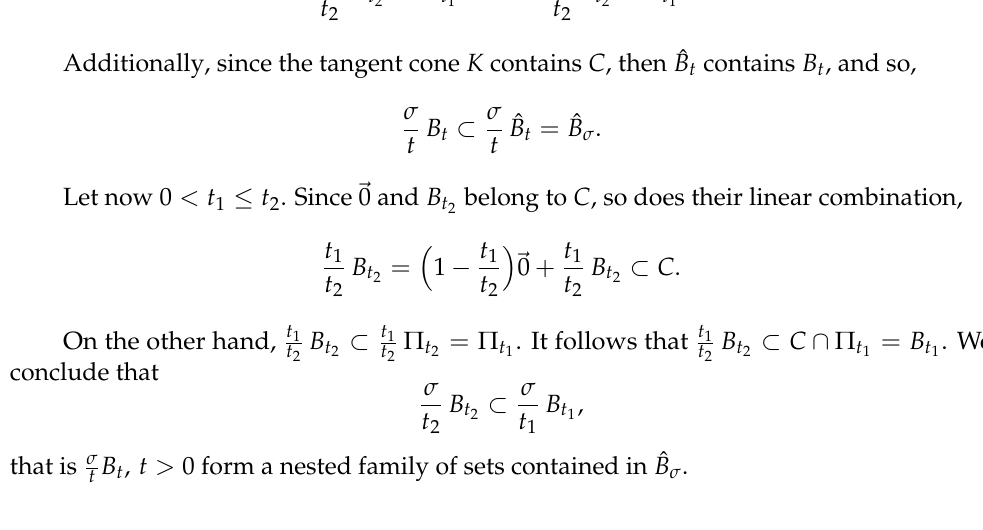
, the cutting planes Π 0 is conical. 0